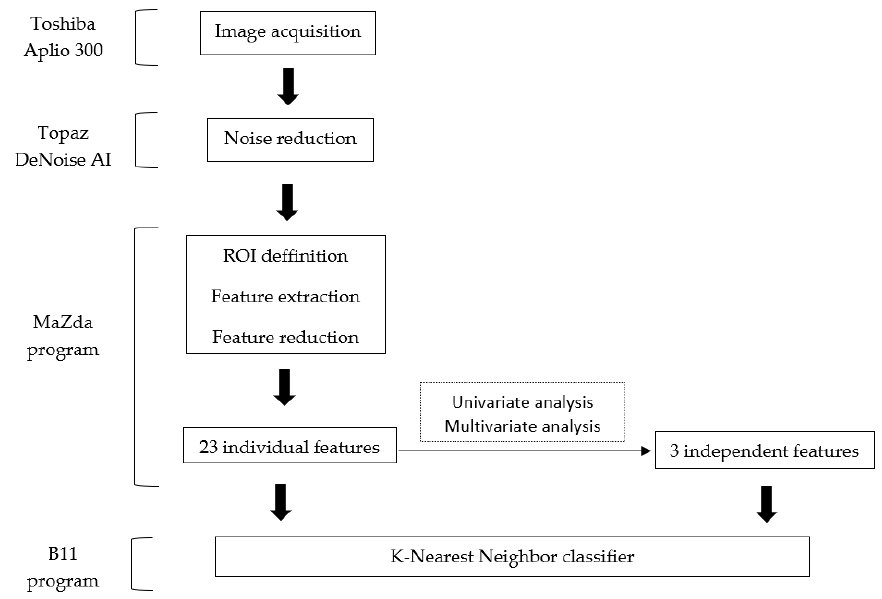
Figure 2. Workflow diagram. ROI, region of interest.